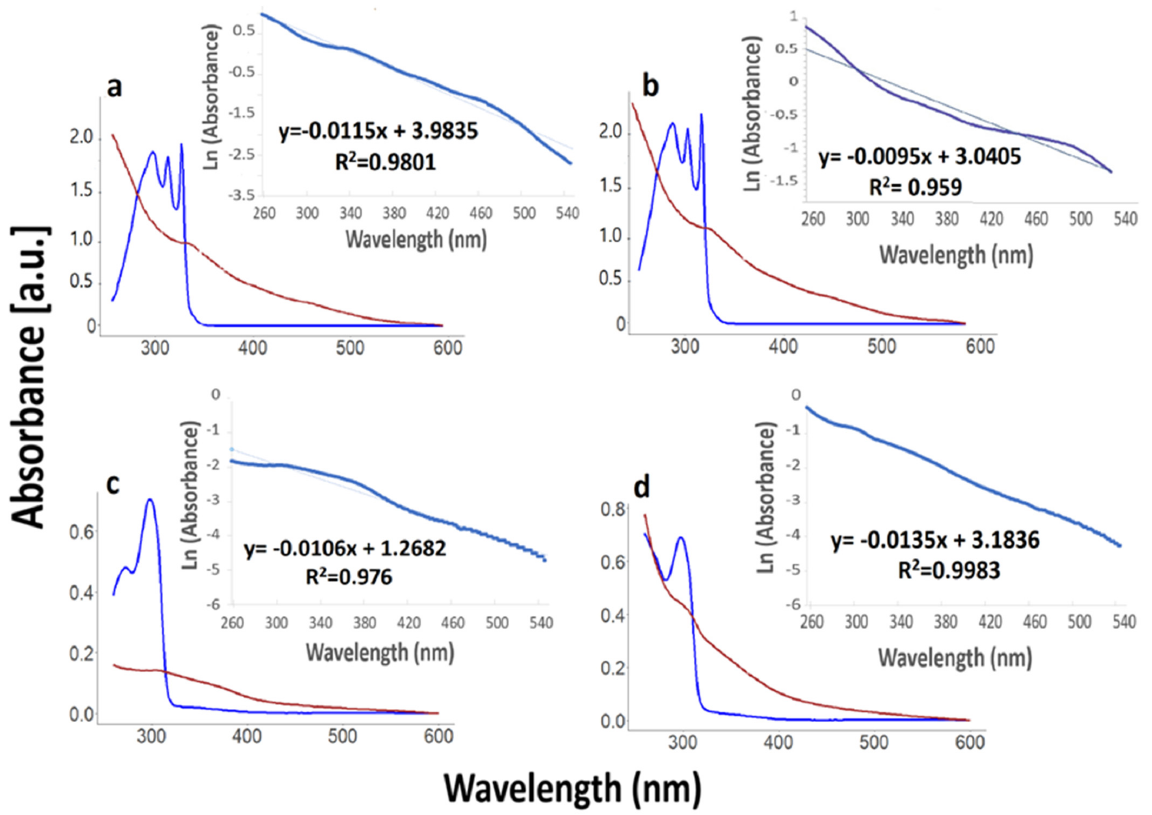
Figure 1. Absorbance spectra 1,8-DHN ( a ) and 1,8-DHN with 5% H 2 O 2 ( b ), 5,6-DHI ( c ), and 5,6-DHI with 5% H 2 O 2 ( d ). (Blue): initial 1,8-DHN or 5,6-DHI. (Brown line): After UV irradiation and 10 days aging for 1,8-DHN and 4 days aging for 5,6-DHI. All samples were diluted in water by 1:20. Insets: Log-linear plots of absorbance for oxidized/aged 1,8-DHN ( a ) with a spectral slope of − 0.011, and 1,8-DHN with 5% H 2 O 2 ( b ) with a spectral slope of − 0.0095, 5,6-DHI ( c ) with a spectral slope of − 0.010, and 5,6-DHI with 5% H 2 O 2 ( d ) with a spectral slope of − 0.013. The solid lines represent the log-linear absorption trends for each sample, and the dashed lines represent the best fitted line according to the calculated equations demonstrated on each linear plot. Original 1,8-DHN solution: pH = 6.0, original 5,6-DHI solution: pH = 6.5, aged 1,8-DHN: pH = 7.0, aged 5,6-DHI: pH = 7.0.